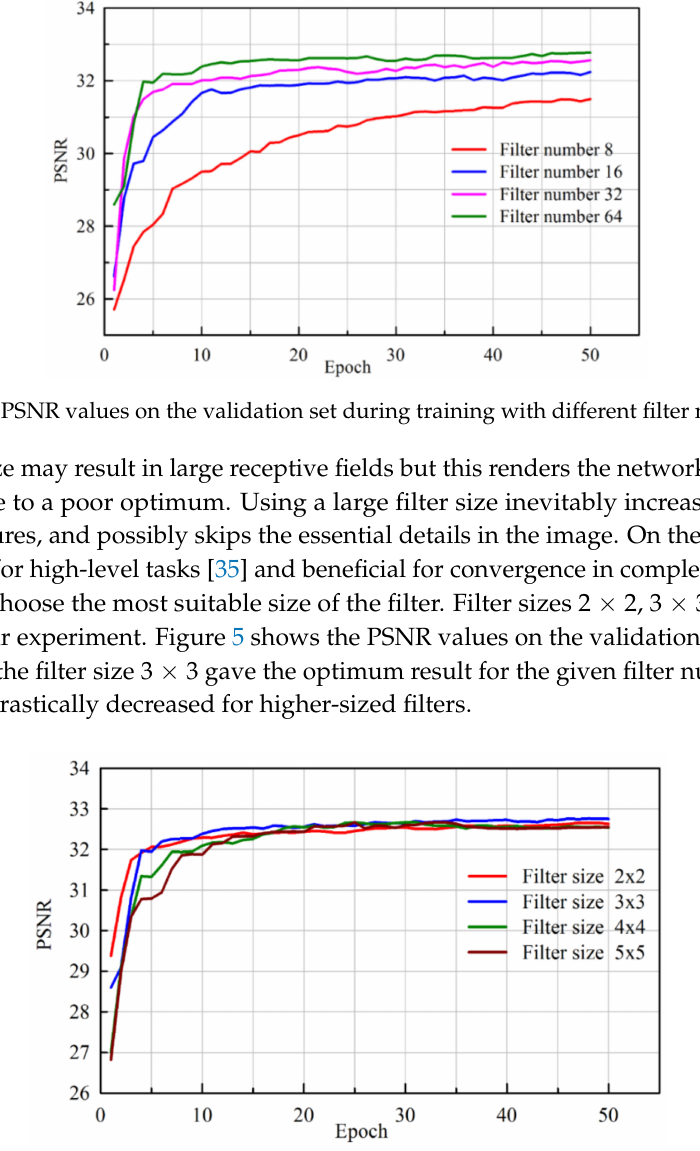
Figure 5. PSNR values on the validation set during training with different filter